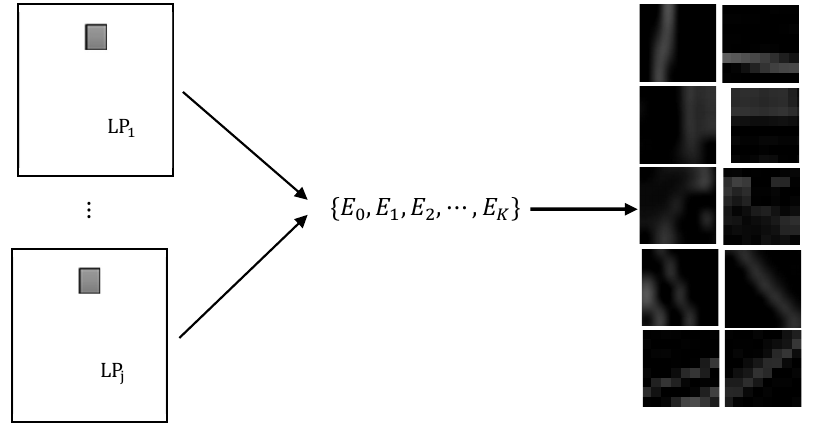
Figure 4. Using ASR’s dictionary composition and